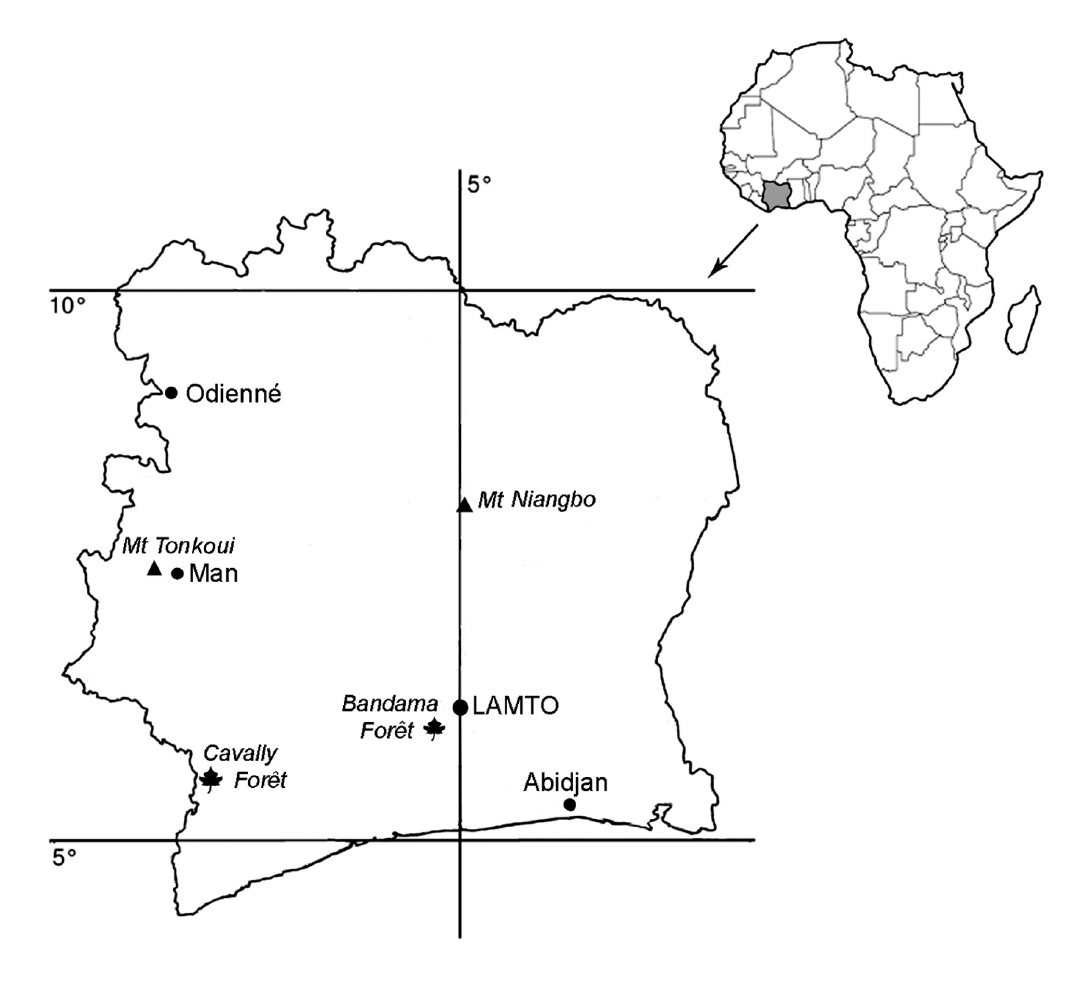
Fig. 1. Location of J.-C. Ledoux’s collecting sites of spiders in Ivory